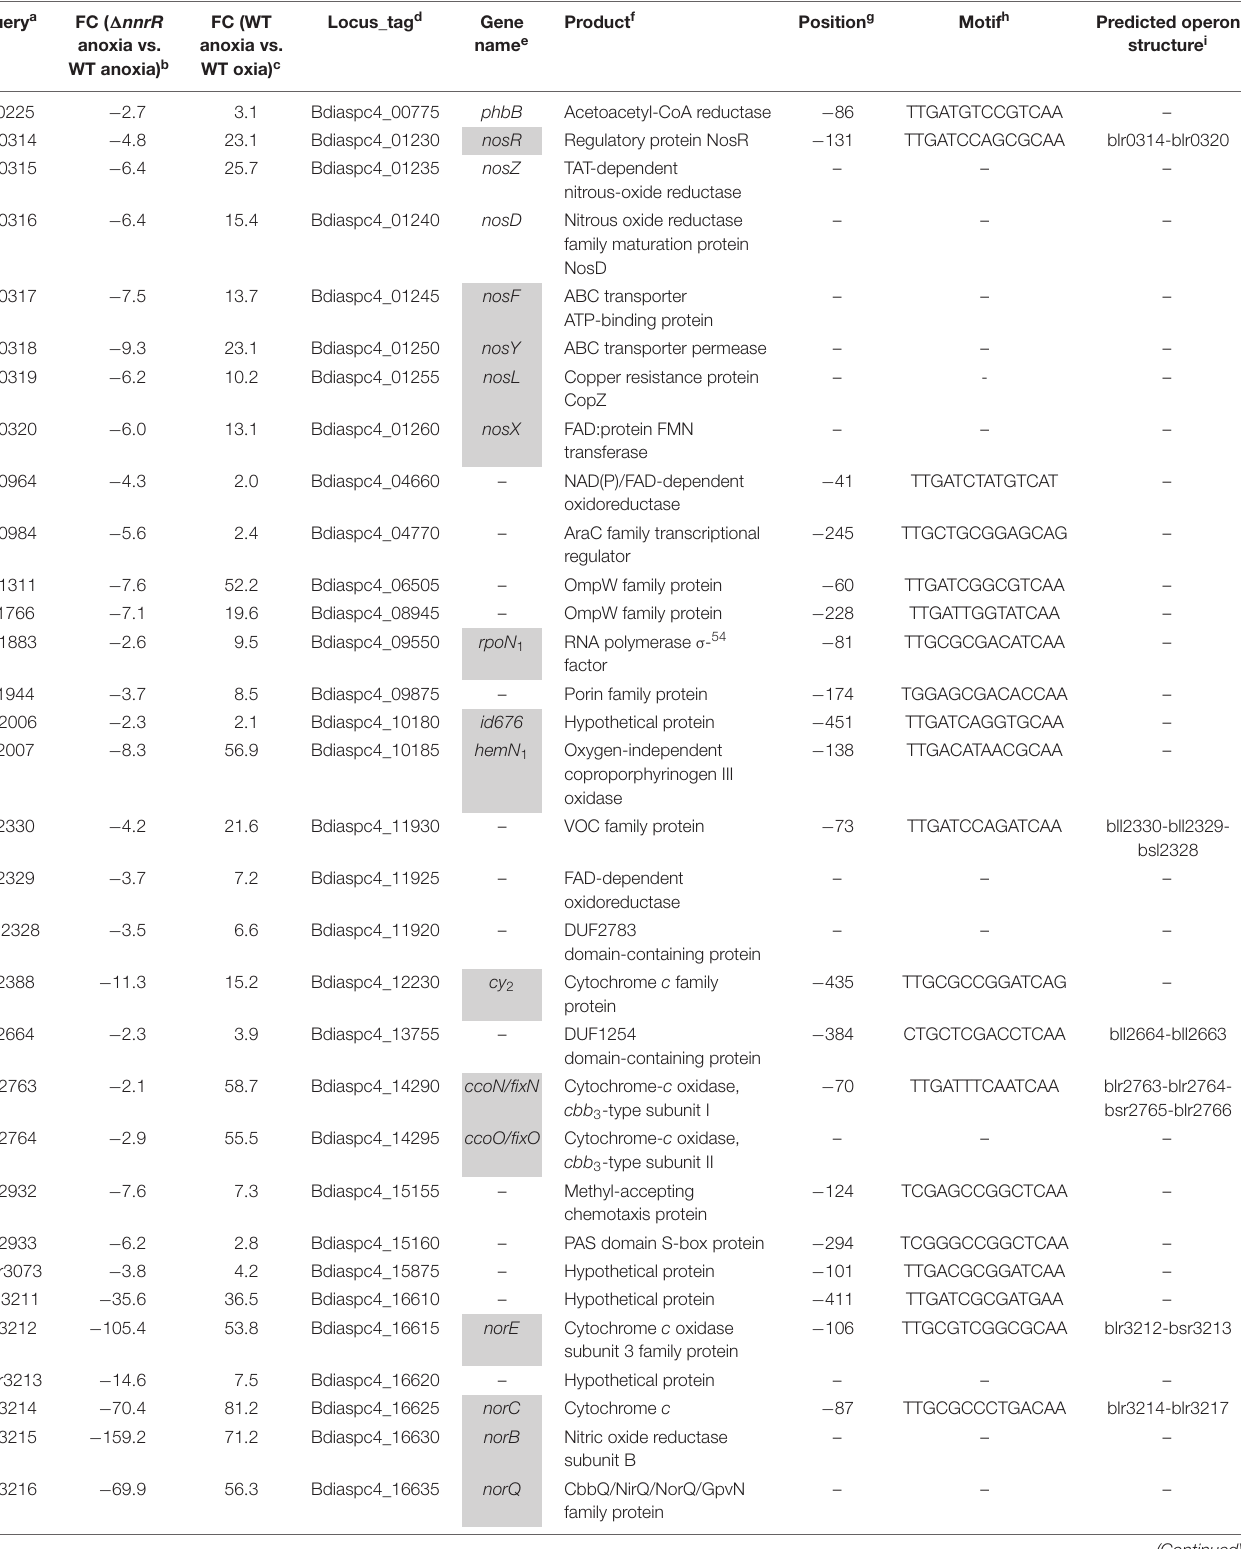
TABLE 1 | List of the 60 genes belonging to 42 putative FixK 2 box-associated transcription units whose expression is downregulated in the nnrR mutant in comparison to the WT, both cultured under anoxic denitrifying conditions, and at the same time are induced in the WT in anoxic denitrifying conditions compared to oxic conditions. Query a FC ( (cid:49) nnrR anoxia